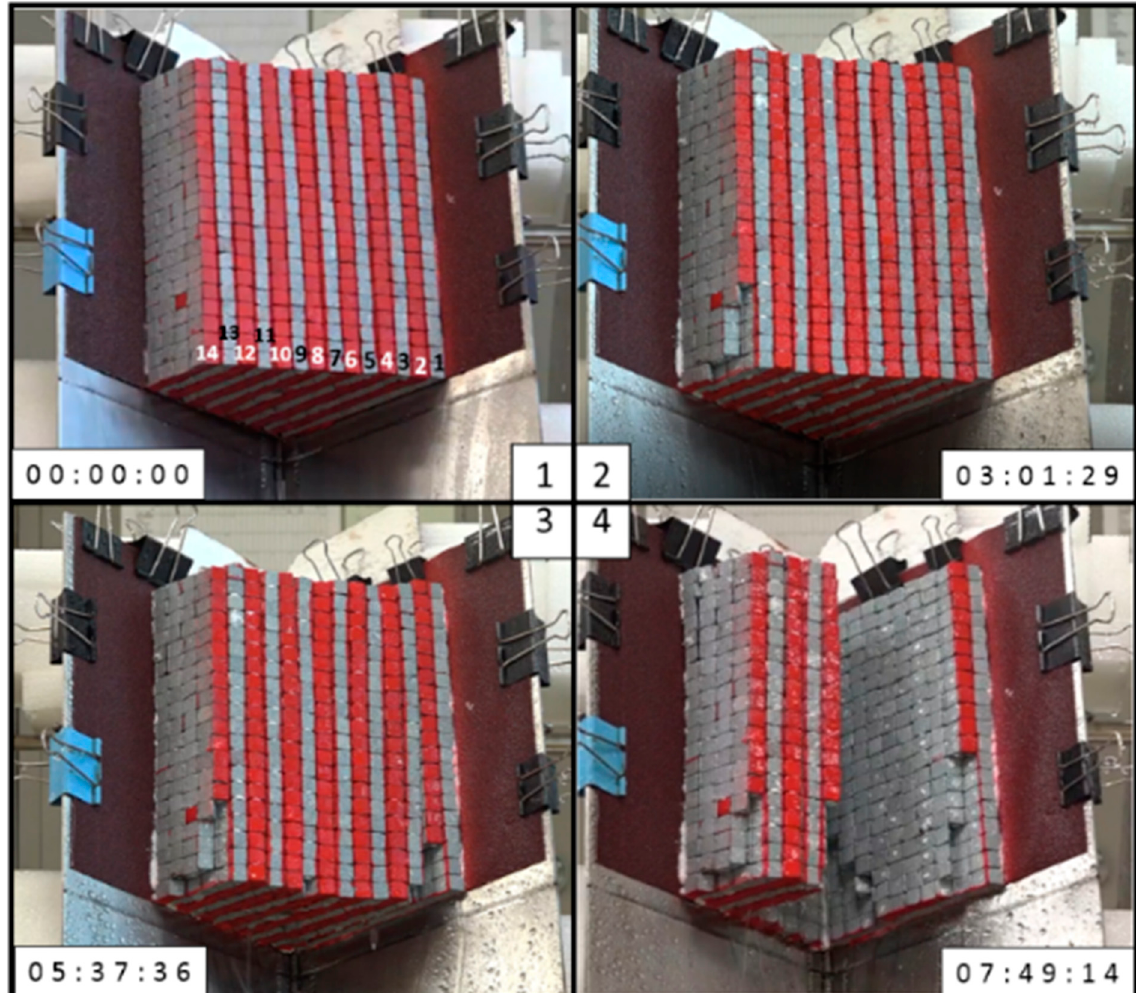
Figure 11. Physical Model F ( i a = 70° and ω 1 = ω 2 = 45°).